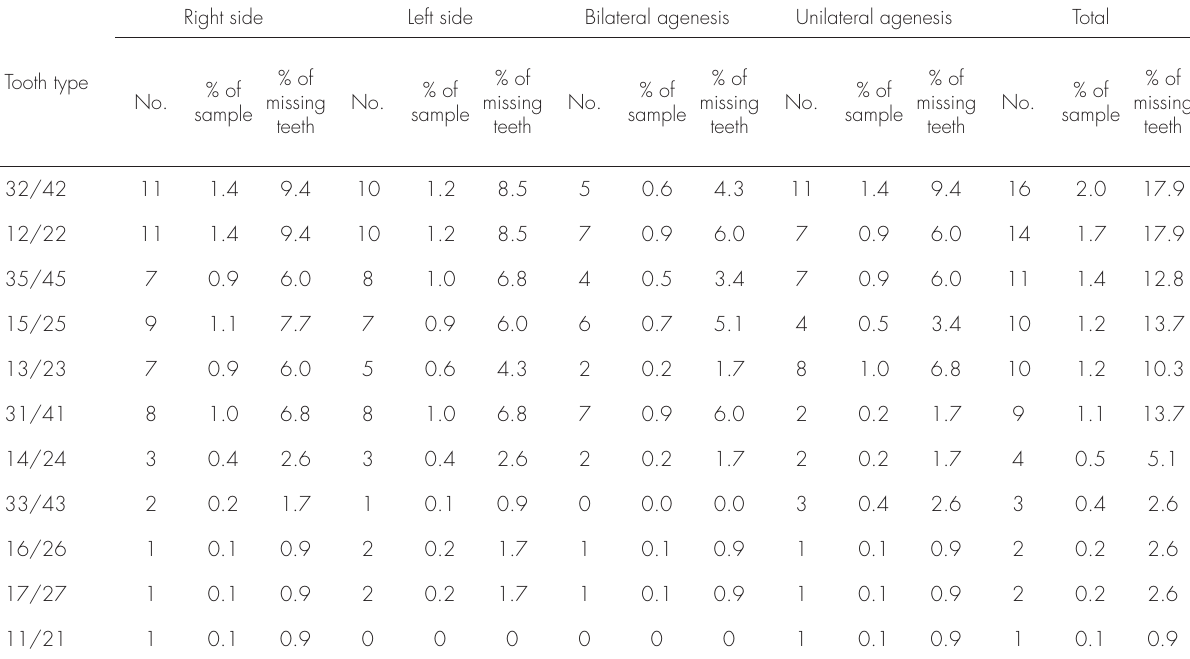
Table III. Hypodontia according to side and uni- or bilateral occurrence.